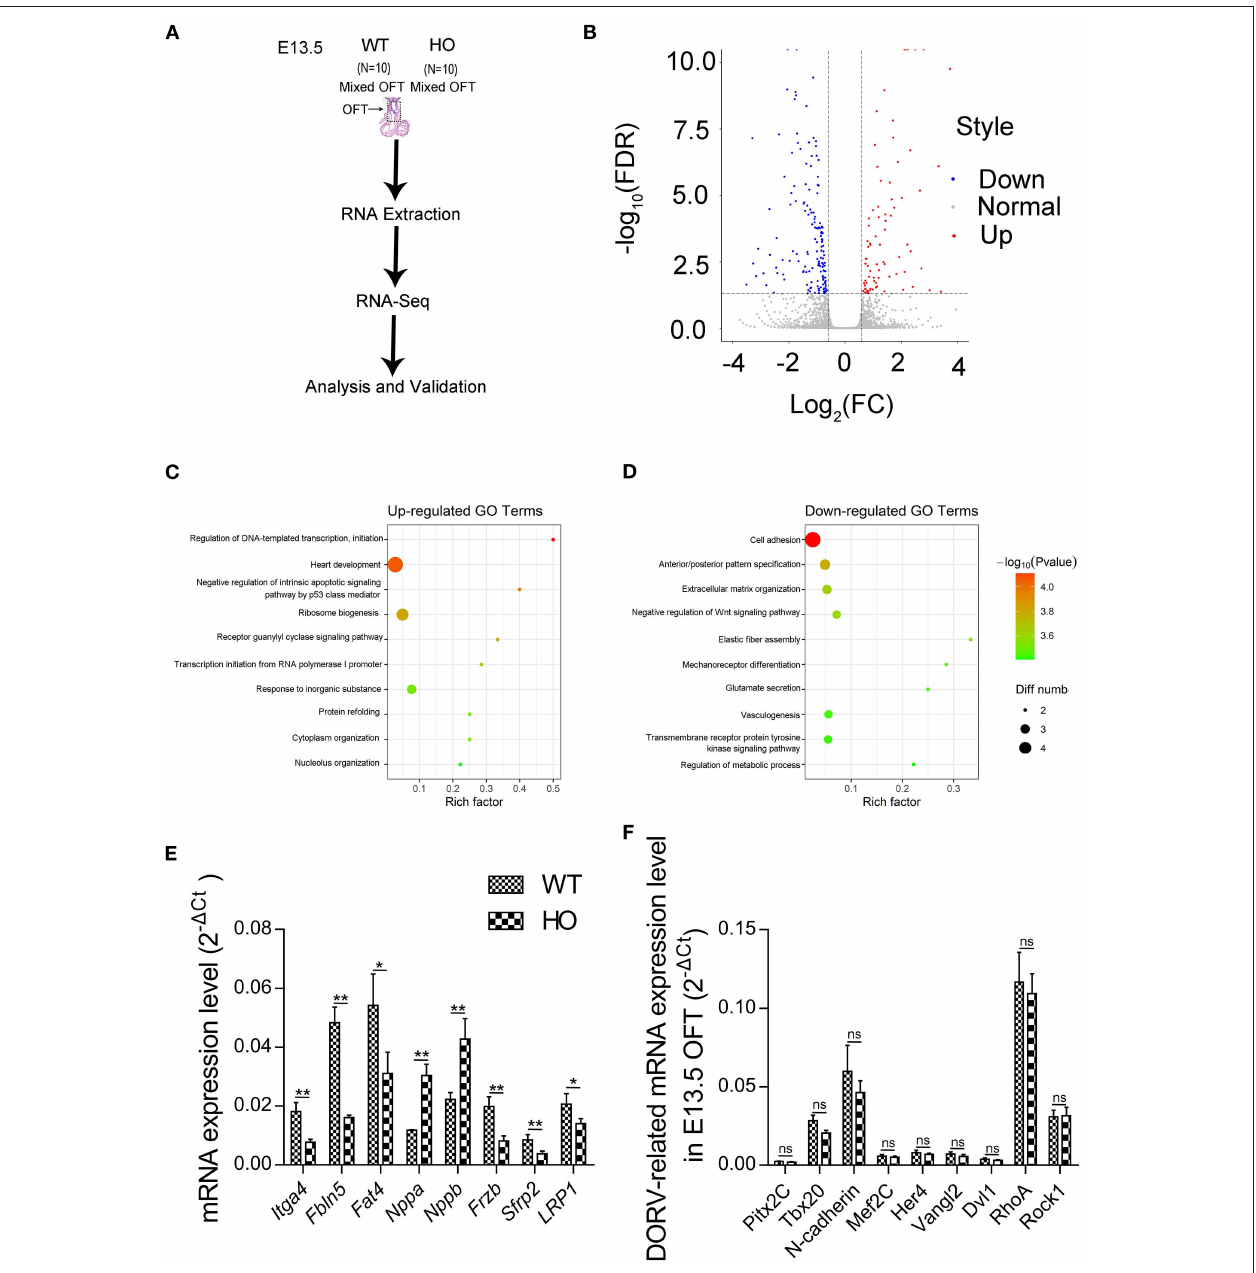
FIGURE 5 | Transcriptomic analysis reveals the mechanism underlying the cardiac OFT defect in SNX17-KO embryos. (A) Experiment design. (B) Volcano plot illustrating differentially expressed genes (DEGs) of the cardiac OFT isolated from E13.5 mutants and control embryos. Red and blue dots denote upregulated and downregulated differentially expressed genes, respectively. (C) The top 10 most enriched GO terms related to biological processes for upregulated DEGs (sorted by p -value size). Rich factor refers to the GO term enrichment, a ratio of the number of the GO term A DEGs in our RNA-seq data to the number of all genes of the GO term A in the GO database. (D) Top 10 most enriched GO terms related to biological processes for downregulated DEGs. (E) Some genes involved in heart development, cell adhesion, and the Wnt signaling pathway were verified by qRT-PCR. Significant differences were observed in levels of mRNA expression between WT and HO OFTs. n = 5 per groups. (F) No significant differences were observed in levels of mRNA expression of DORV-related genes. n = 5 per groups. GO, Gene Ontology; qRT-PCR, quantitative real-time PCR. * p < 0.05; ** p <